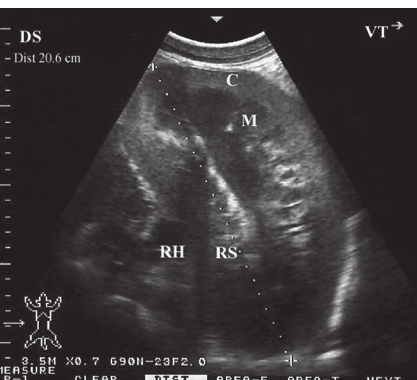
Figure 5: Ultrasonogram of a longitudinal section of the right kidney in a healthy camel. The image was taken from the upper right flank. RH � renal hilus; DS � dorsal; VT � ventral.